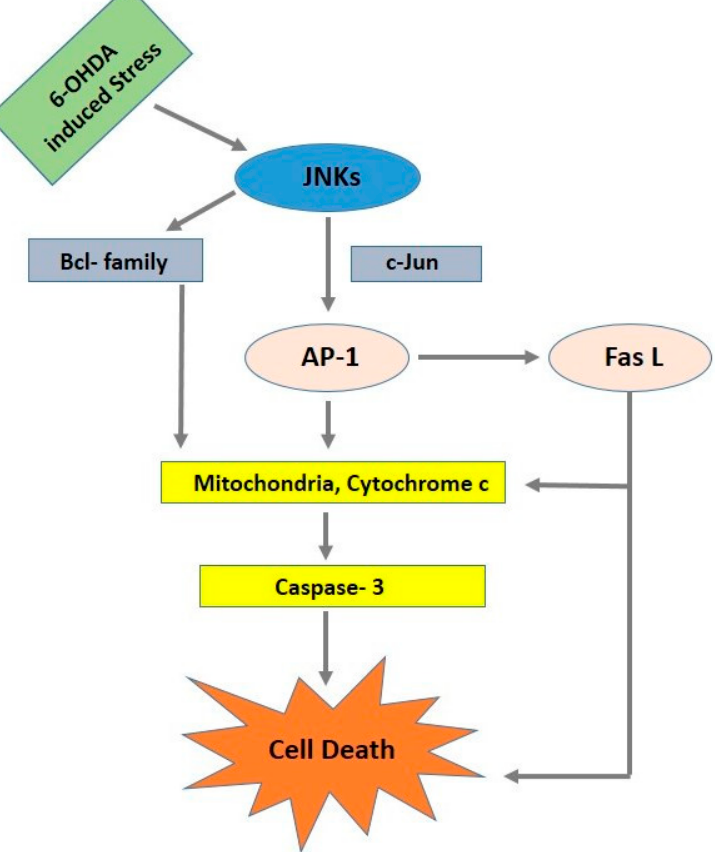
Figure 1. In response to various stressors, c-Jun N-terminal kinase (JNK) is activated and phosphorylates c-Jun, which increases the activity of activating protein-1 (AP-1). AP-1 modulates the transcription genes such as Fas ligand ( FasL ) to induce apoptosis via an extrinsic pathway. JNK also appears to activate non-nuclear substrates (such as Bcl-2 family members) to promote cell death via an intrinsic pathway. 6-OHDA: 6-hydroxydopamine.